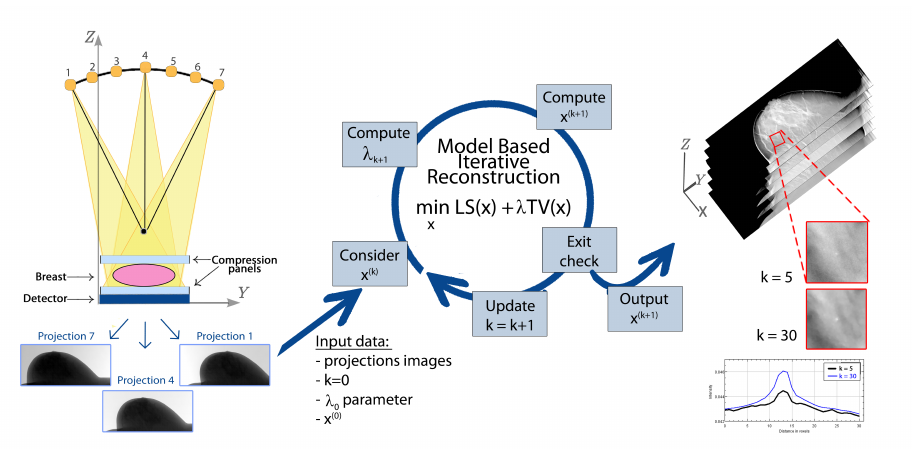
Figure 1. Scheme of the Digital Breast Tomosynthesis (DBT) reconstruction process. On the left, a draft of the frontal (coronal) section of a DBT system acquiring projection images of the breast; in the center, a chart representing the k th iteration of the algorithm computing the sequence { x ( k ) } k of approximate solutions by solving the model-based minimization problem; on the right, the evaluation of reconstructed volumes by inspection of cancer objects of